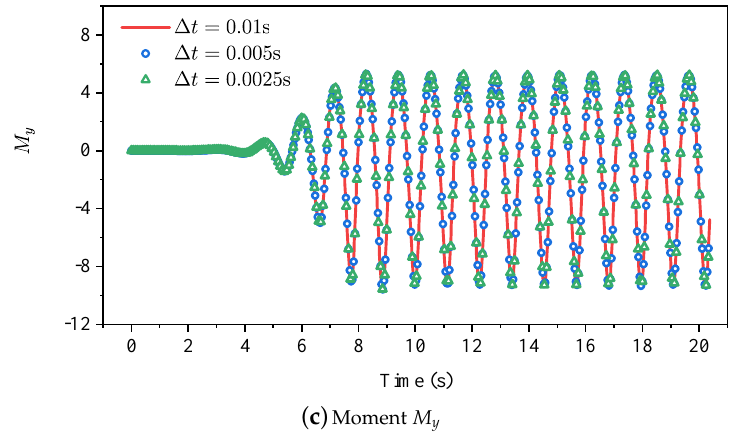
( c ) Moment M y Figure 5. Evolutionary profiles of the hydrodynamic loads F x , F z , and M y using three different time increments with N = 280,380.